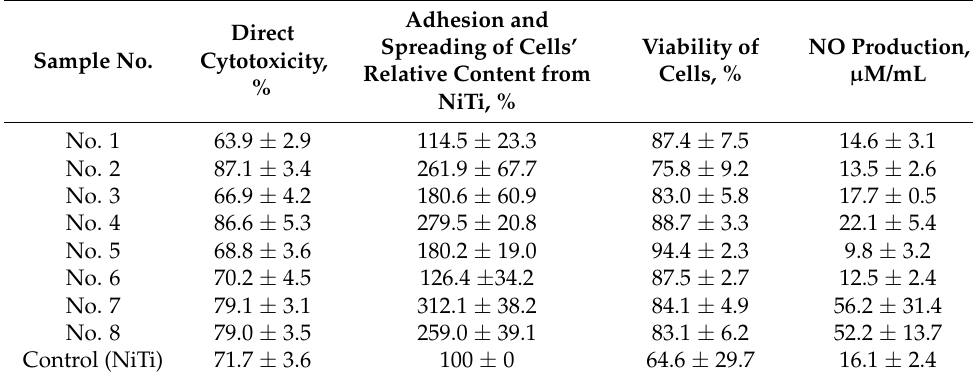
Table 2. Cytocompatibility test results. Data (n = 6 in each group) are presented as M ± SD.